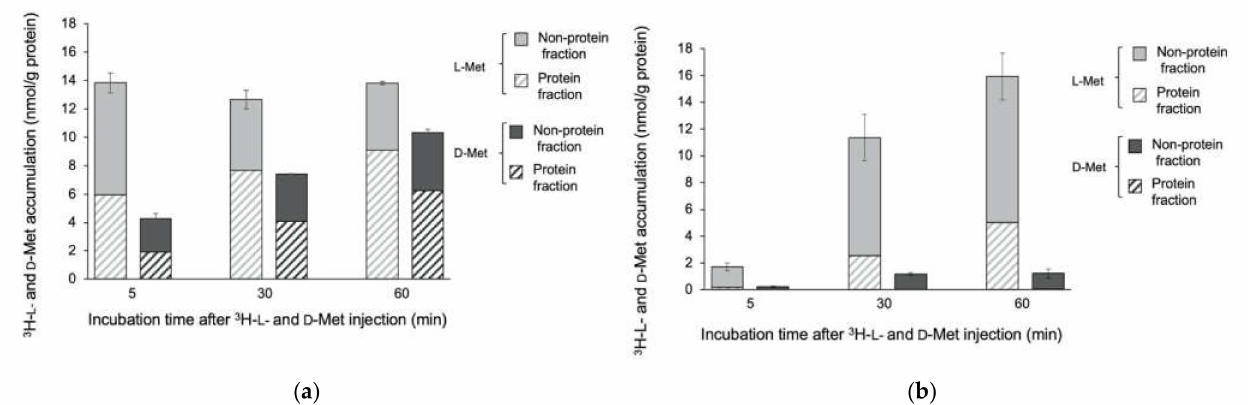
Figure 3. Accumulation of 3 H-L-Met and 3 H-D-Met in ( a ) E. coli EC-14 at 4 h after incubation and in ( b ) HaCaT cells at 5, 30, and 60 min after 3 H-L-Met and 3 H-D-Met injection. The accumulation